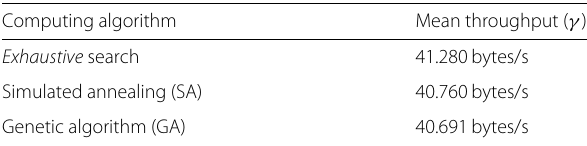
Table 2 Mean throughput values obtained for 500 randomly simulated nodes and for the three different approaches of solving Eq.